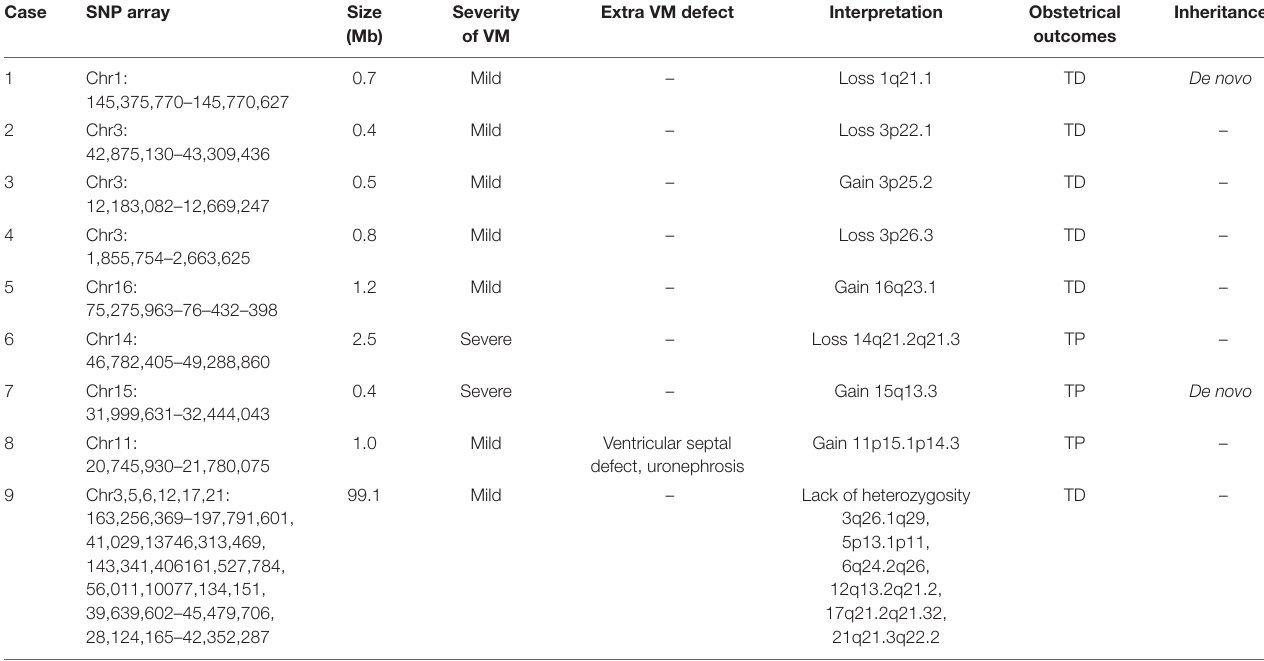
TABLE 3 | The variants of uncertain clinical significance in VM fetuses.